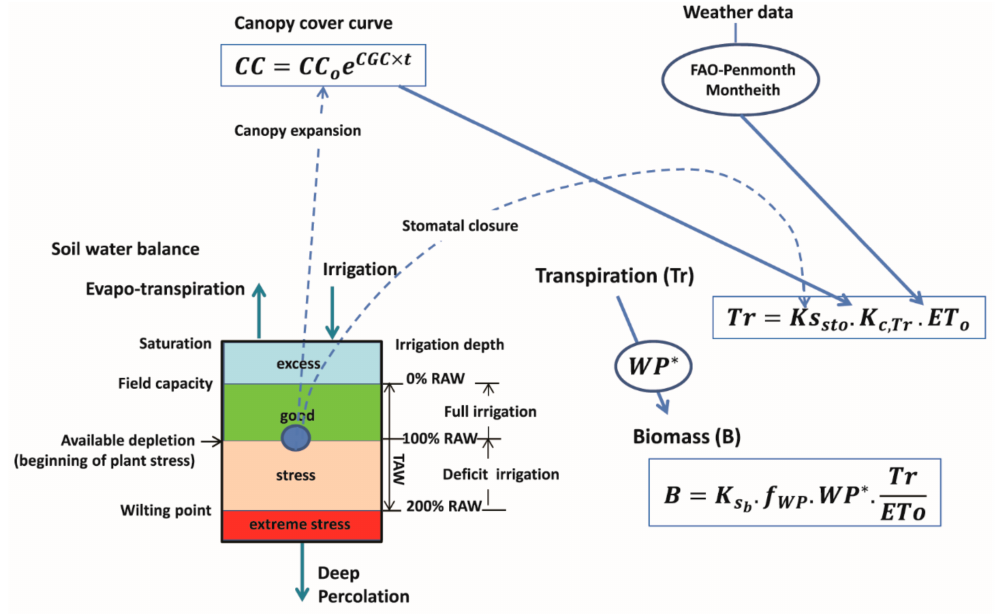
Figure 4. Schematic representation of the crop response to varied RAW threshold irrigation scenarios simulated by AquaCrop (adjusted from [77]). RAW is readily available water content, TAW is total available water content, CC is the simulated canopy cover, CC o is initial canopy cover size, CGC is canopy growth coefficient in fraction per growing degree day (GDD), Ks sto is the water stress for stomatal closure, Kc Tr is the crop transpiration coefficient (determined by CC and Kc Tr,x at maximum canopy cover), ETo is the reference evapotranspiration, Ks b is the stress coefficient for low-temperature effects on biomass production, f WP is the adjustment factor to account for differences in chemical composition of the vegetative biomass and harvestable organs, WP* is the normalised water